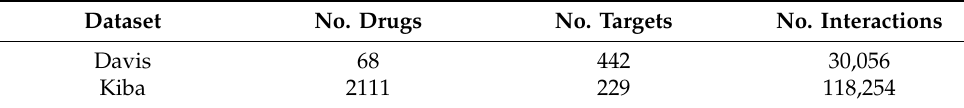
Table 1. Davis and Kiba datasets’ characteristics.